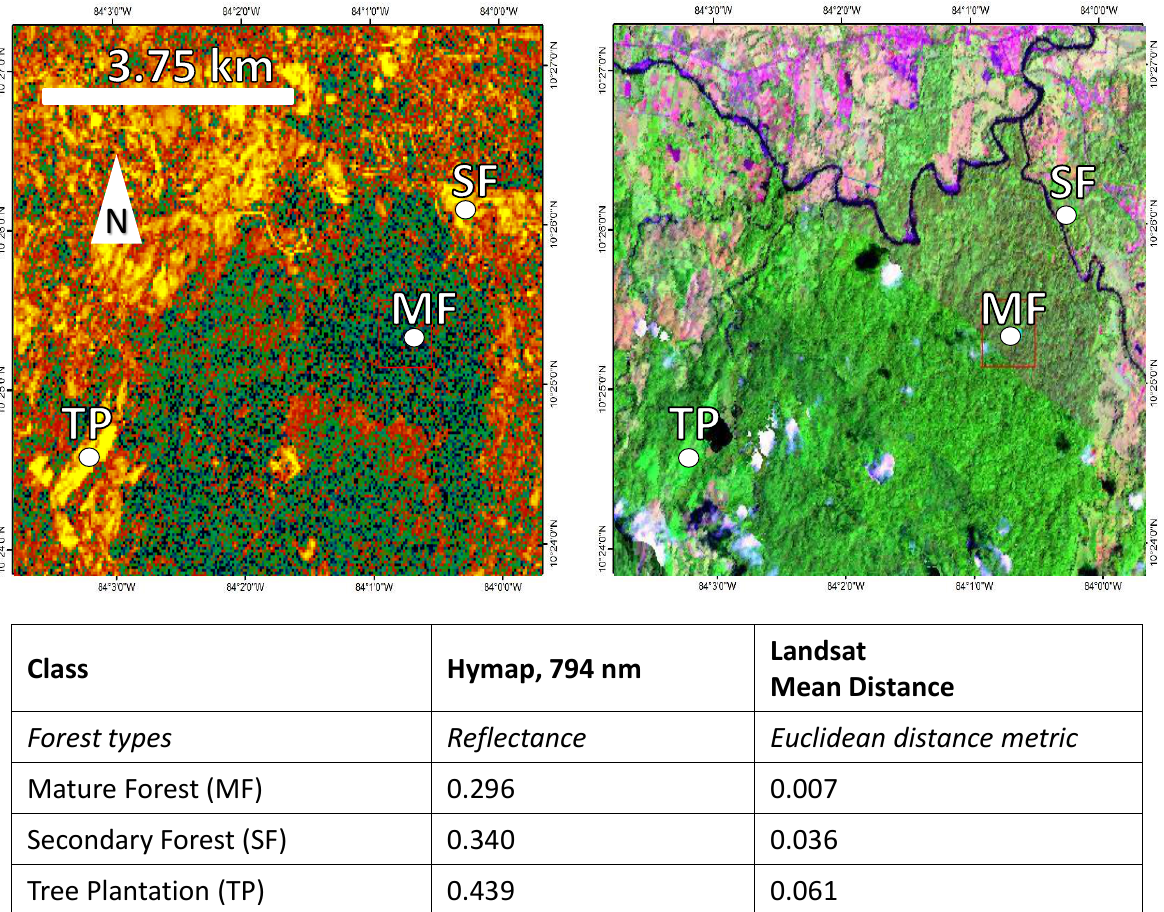
Figure 3. Two images of La Selva Biological Station, with land-use classes labeled at points for illustration, and a table showing the spectral values of the points in each image. Image A ( left ) shows a metric derived from Landsat imagery—the mean of the Euclidean distance (ED) in Band 5 between all four image pairs in a Landsat image stack (1986–2005). Warmer colors signify greater mean change in Band 5 over time; both reforestation and deforestation events show high mean change; Image B ( right ), showing the same area, is a three-band HyMap reflectance composite (593:794:534 nm). To illustrate radiometric variation between images, the highest spectral contrast between two image tiles in the entire HyMap image mosaic can be seen just below the mature forest point, in the bottom left corner of the red